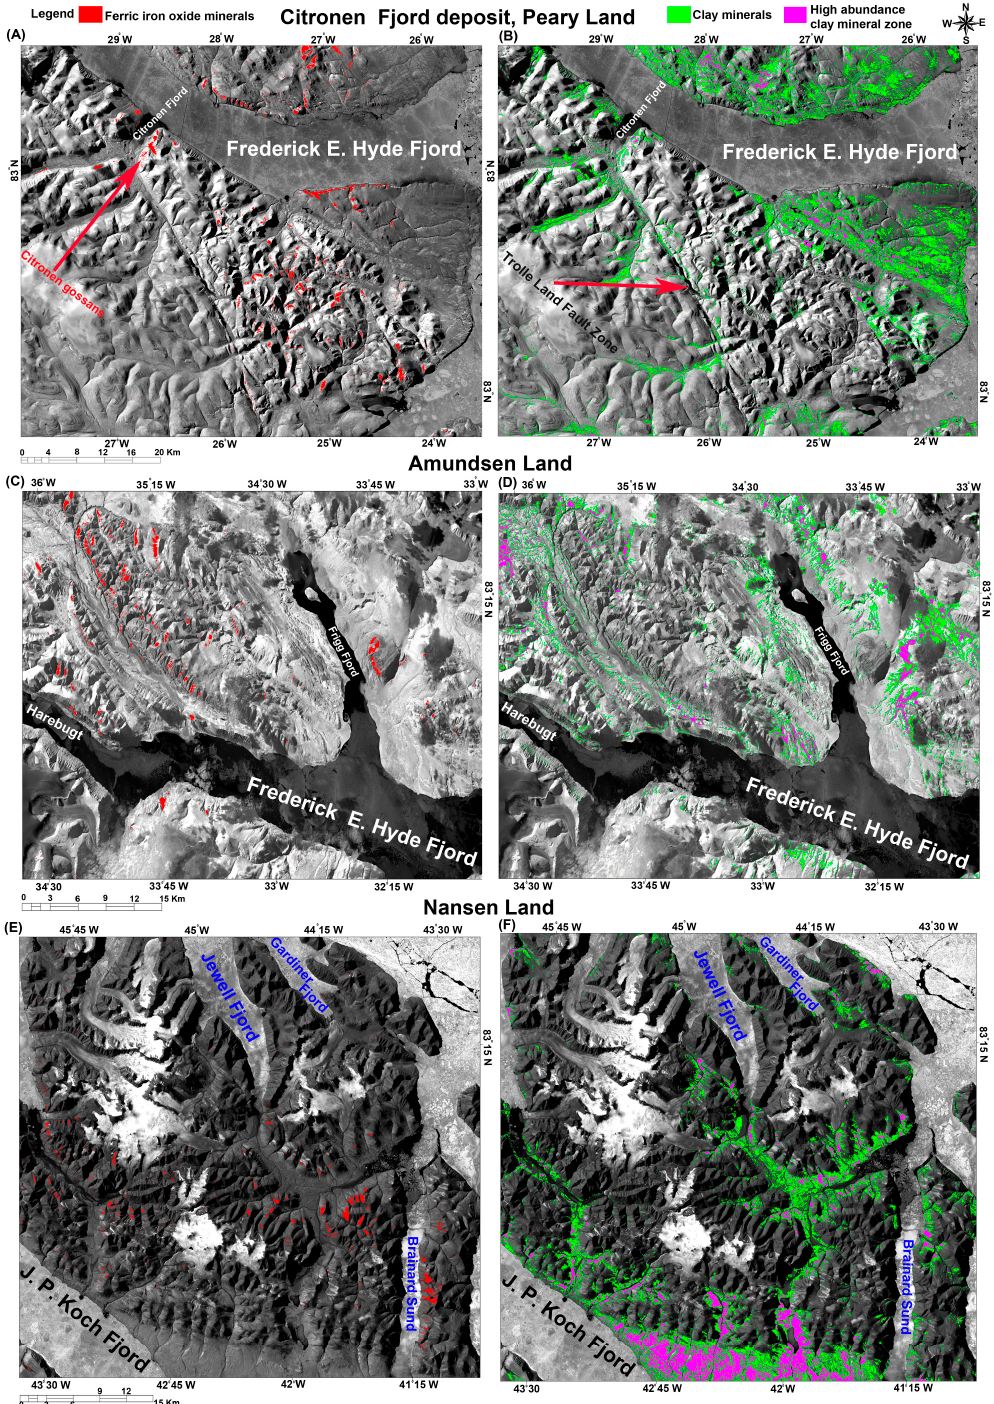
Figure 7. ICA images of Landsat-8 spatial subset scenes considered for CD Zn–Pb mineralization. ( A ) ICA2 image showing ferric iron oxide/hydroxide minerals (gossan) for the subset of Citronen Fjord Zn–Pb deposit; ( B ) ICA5 image showing clay minerals for the subset of Citronen Fjord Zn–Pb deposit; ( C ) ICA2 image showing ferric iron oxide/hydroxide minerals (gossan) for the subset of the Amundsen Land; ( D ) ICA5 image showing clay minerals for the subset of the Amundsen Land; ( E ) ICA5 image showing ferric iron oxide/hydroxide minerals (gossan) for the subset of the Nansen Land; ( F ) ICA3 image showing clay minerals for the subset of the Nansen Land.